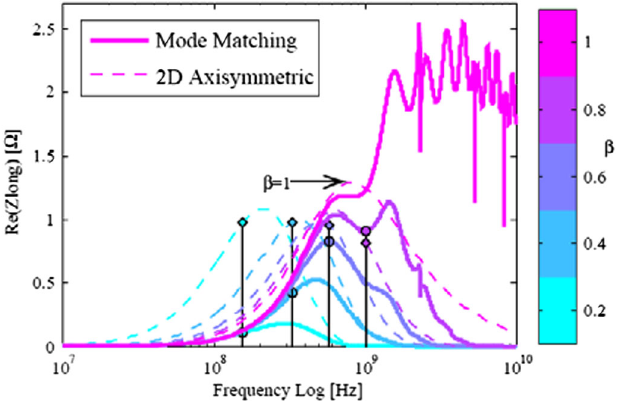
FIG. 18 (color online). Resistive wall impedance for different β (0.2, ...,1). Impedance decreases accordingly with beam field decaying. Region III has conductivity σ ¼ 0 . 05 S=m , b ¼ 5 cm, t ¼ 15 cm, L ¼ 2